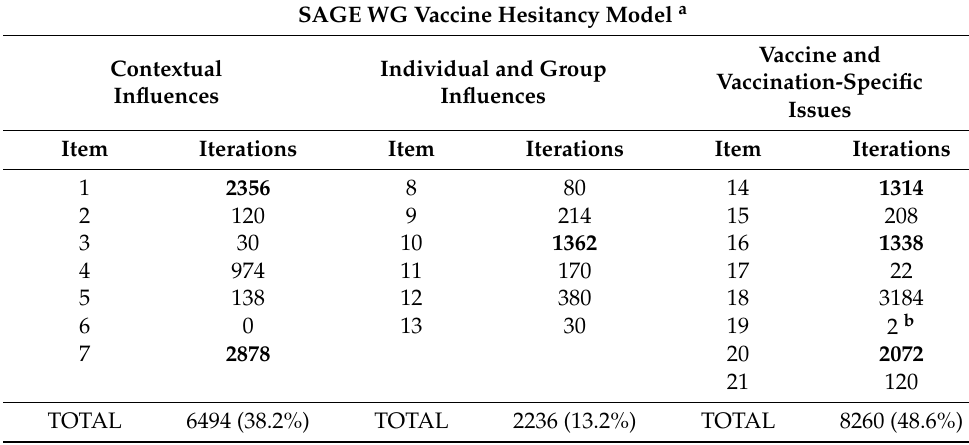
Table 3. Summary of how the study participants’ answers to some of the open questions are related to the determinants of vaccine hesitancy in the model developed by SAGE